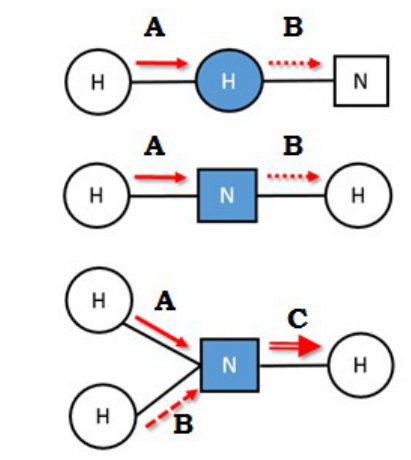
Fig. 15. The stakeholders diagram template, used by SAC to identify the multiple players involved in the development of an artifact. The layers, from the outermost to the innermost, are: community, market, source, contribution, operation and technology.